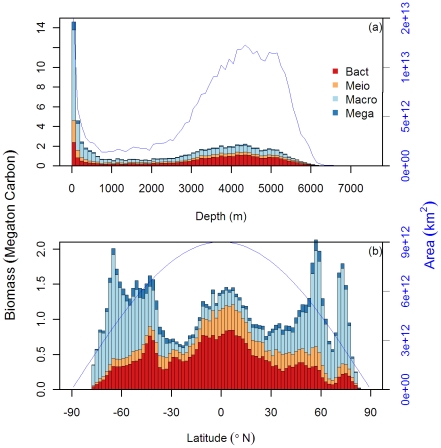
Global zonal integrals of benthic biomass (bars) in unit of megaton carbon based on 100-m bins (a) and 2-latitude-degree bins (b).The blue line shows integrals of seafloor area in unit of square kilometer. Color legends indicate 4 major size classes.